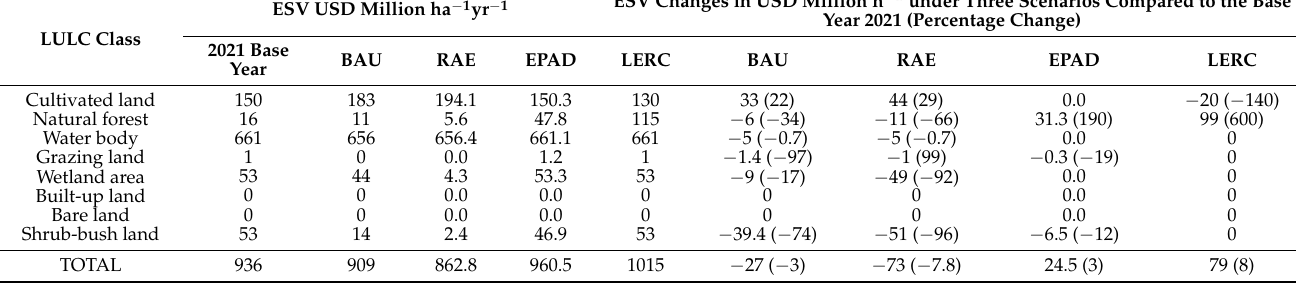
Table 3. The total ES values (ESV) under different LULC change scenarios in million USD ha − 1 yr − 1 (percentage